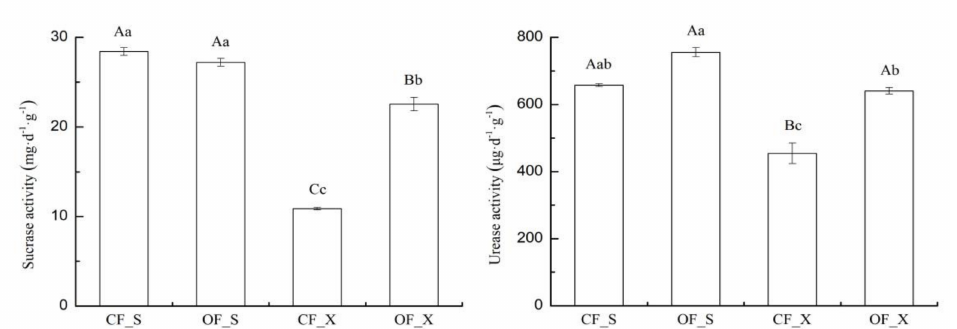
Figure 2. Effects of cultivation patterns on soil enzyme activities in different soil layers. Different lower case letters indicate significant differences among the four treatments at p < 0.05, different upper case letters indicate very significant differences among the four treatments at p < 0.01.